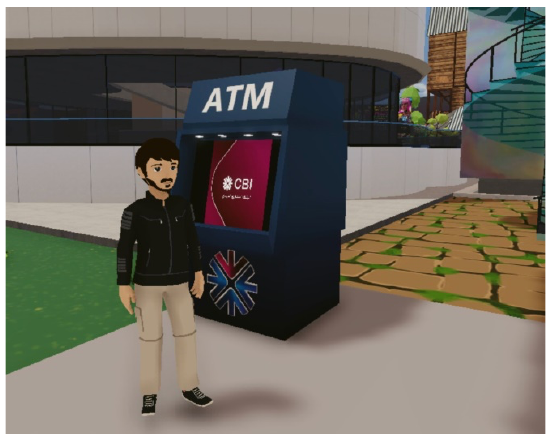
Figure 33: Commercial Bank International’s metaverse Figure 31: Bangalore International Airport (BIAL) in the Metaverse